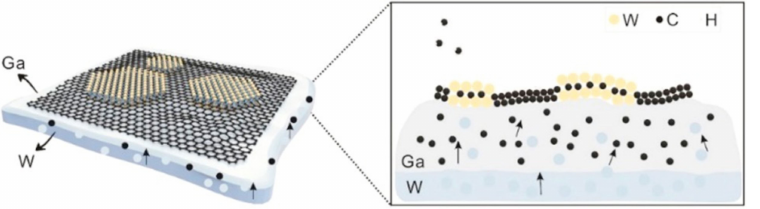
Figure 3. Schematic drawing and cross-view of 2D lateral WC-graphene (WC-G)